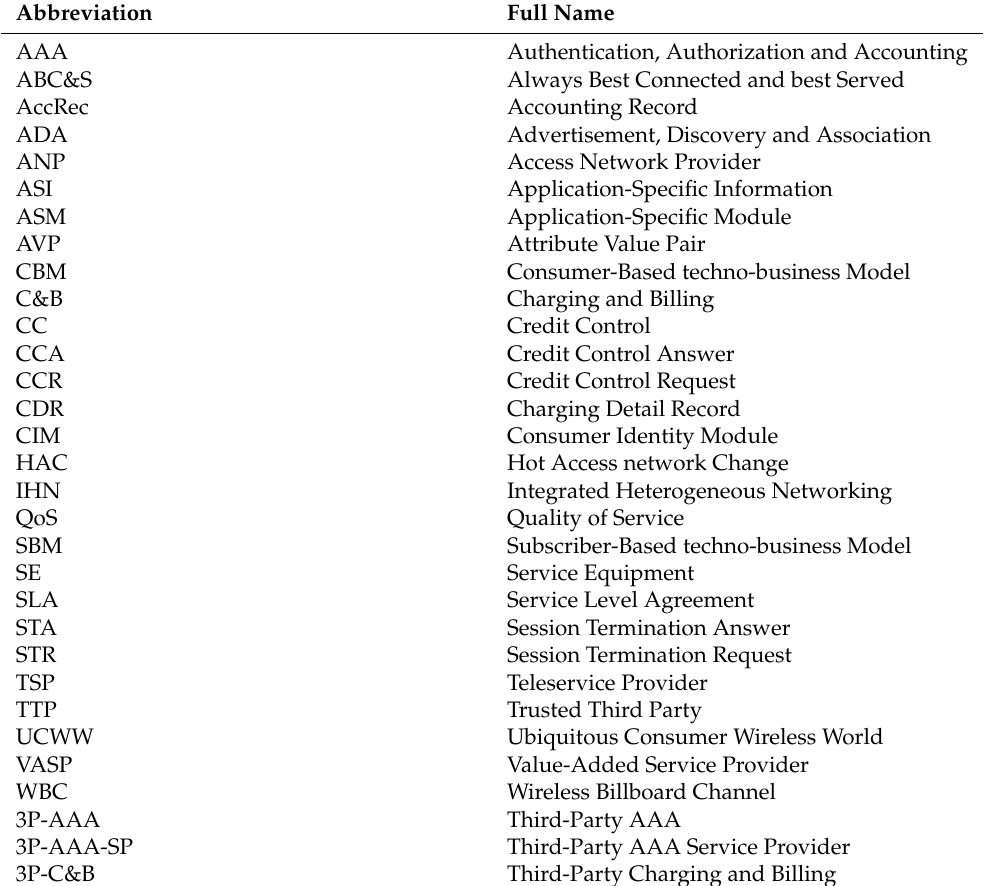
Table A1. Main abbreviations used in the